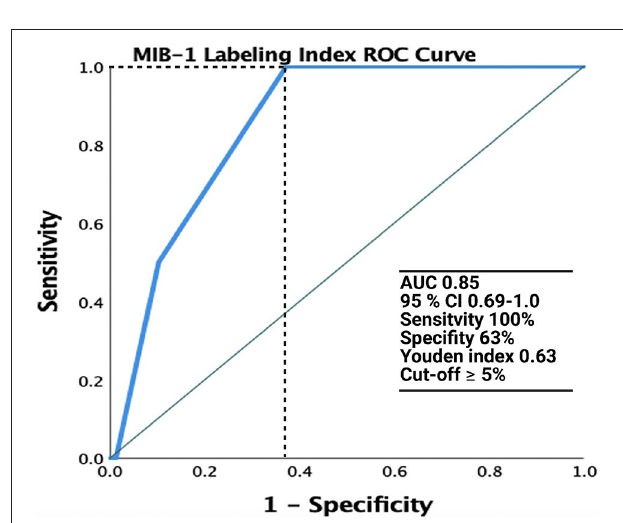
FIGURE 2 | Receiver operating characteristic (ROC) curve illustrating the performance of the MIB-1 labeling index in the prediction of recurrence of spinal meningiomas. The green line represents the reference and the MIB-1 labeling index is shown at the blue line. AUC was 0.85 (95% CI: